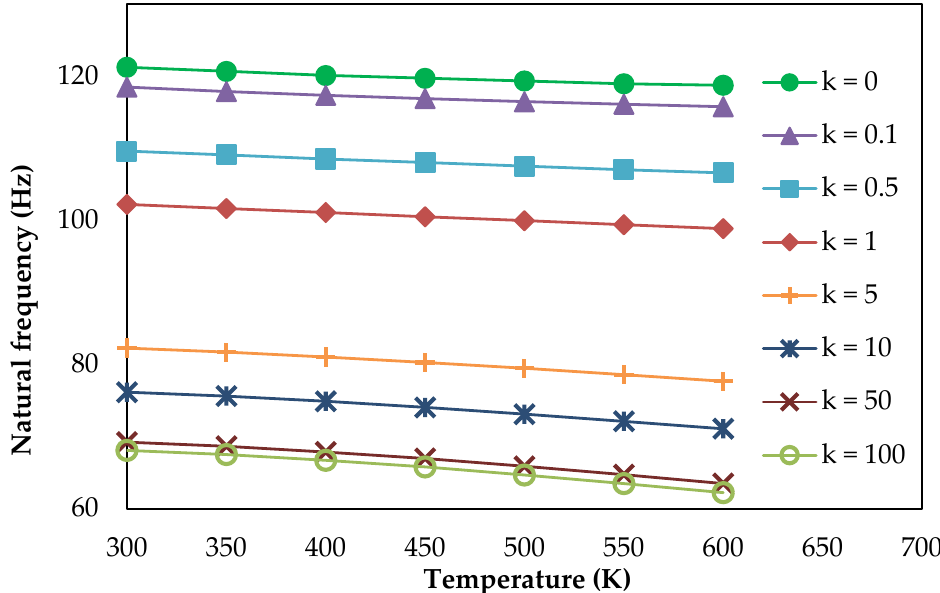
Figure 8. Variation of the natural frequency of an aluminum/aluminum oxide FGM shell in a uniform thermal field for different material composition for re-entry vehicle nose structures.